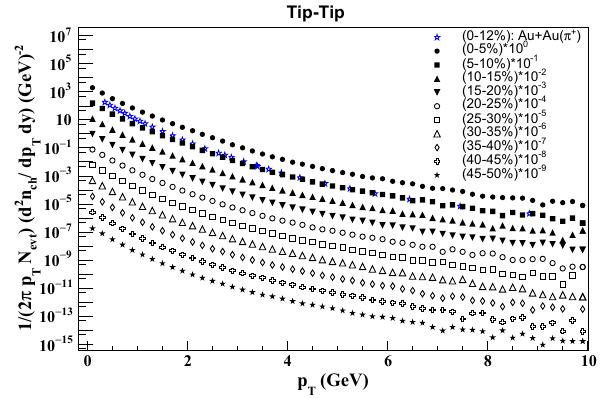
Fig. 16 Normalized transverse momentum distribution of charged hadrons in tip–tip configuration for various centrality classes